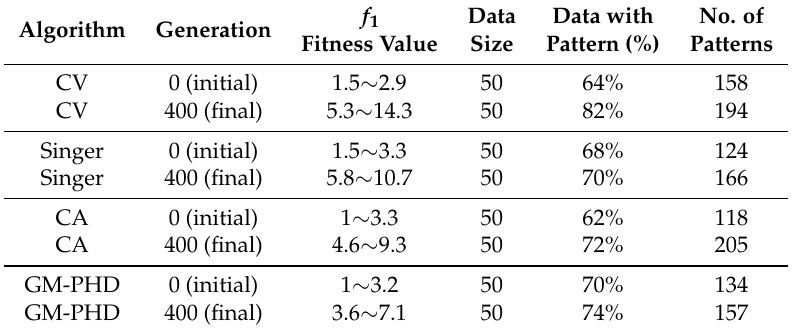
Table 2. Statistics of snapshot convergence pattern (with noise) for the four tracking